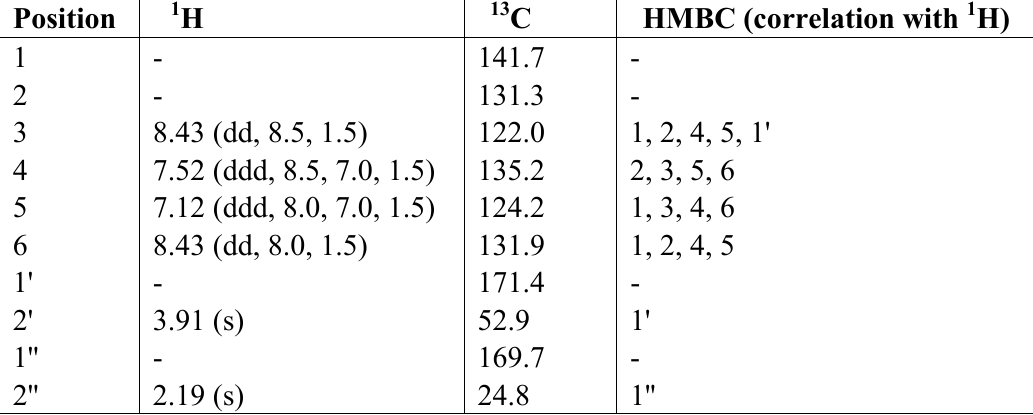
OD, J in Hz and δ in 3